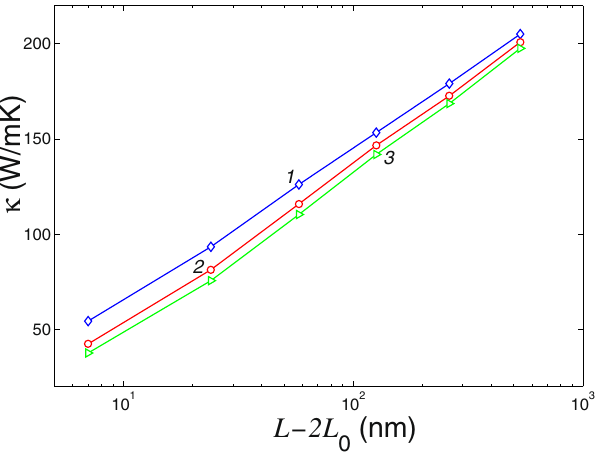
Figure 12. Coefficient of thermal conductivity κ vs. the length of the central part of the nanoribbon L − 2 L 0 for ideal nanoribbon (curve 1), for nanoribbon with an edge pilar with the lengths L p = 0.245, 0.49 nm (curve 2, 3). Nanoribbon width is D = 1.228 nm, temperature T = 300 K .